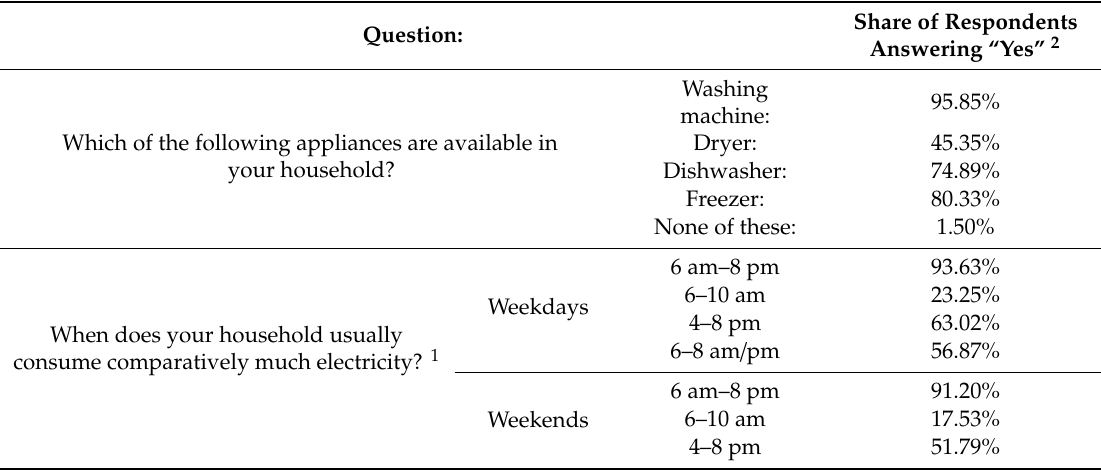
Table 3. Appliance ownership / times of high electricity